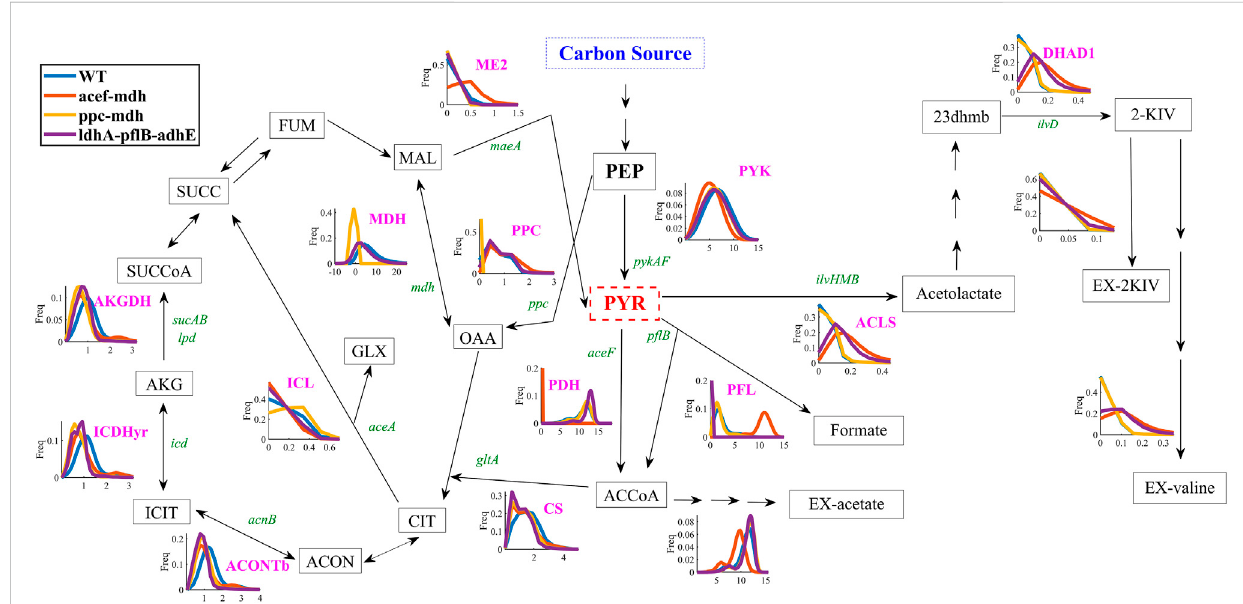
FIGURE 4 Flux frequency and variability through central metabolism of E. coli W as predicted by Monte Carlo sampling. Pyruvate kinase reaction (PYK), acetolactatesynthasereaction(ACLS),dihydroxy-aciddehydratasereaction(DHAD1),extracellulartransportof2-KIV(EX-2KIV), extracellulartransportof L-valine (EX-valine), malate dehydrogenase ubiquinone-8 reaction (ME1-2), pyruvate dehydrogenase reaction (PDH), phosphoenolpyruvate carboxylase reaction (PPC), malate dehydrogenase reaction (MDH), extracellular transport of acetate (EX-acetate), extracellular transport of formate (EX- formate), isocitrate lyase reaction (ICL), isocitrate dehydrogenase — NADP reaction (ICDHyr), oxogluterato deshidrogenasa reaction (AKGDH), pyruvate formate lyase (PFL), aconitase (ACONTb), citrate synthase (CS), fumarate (FUM), malate (MAL), oxaloacetate (OAA), succinate (SUCC), succinyl-CoA (SUCCoA), 2-oxoglutarate (AKG), isocitrate (ICIT), cis-aconitate (ACON), citrate (CIT), glyoxylate (GLX), phosphoenolpyruvate (PEP), pyruvate (PYR), Acetyl-CoA (ACCoA), 2,3-Dihydroxy-3-methylbutanoate (23 dhmb). Gene names are shown in